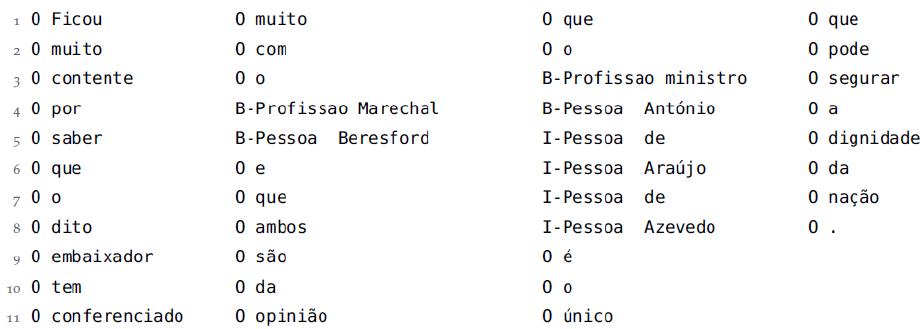
Figure 10. BIO annotation from the Família Araújo de Azevedo